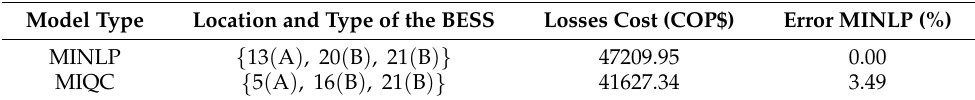
Table 6. Optimal selection and location of the BESSs with the exact MINLP and the proposed MIQC